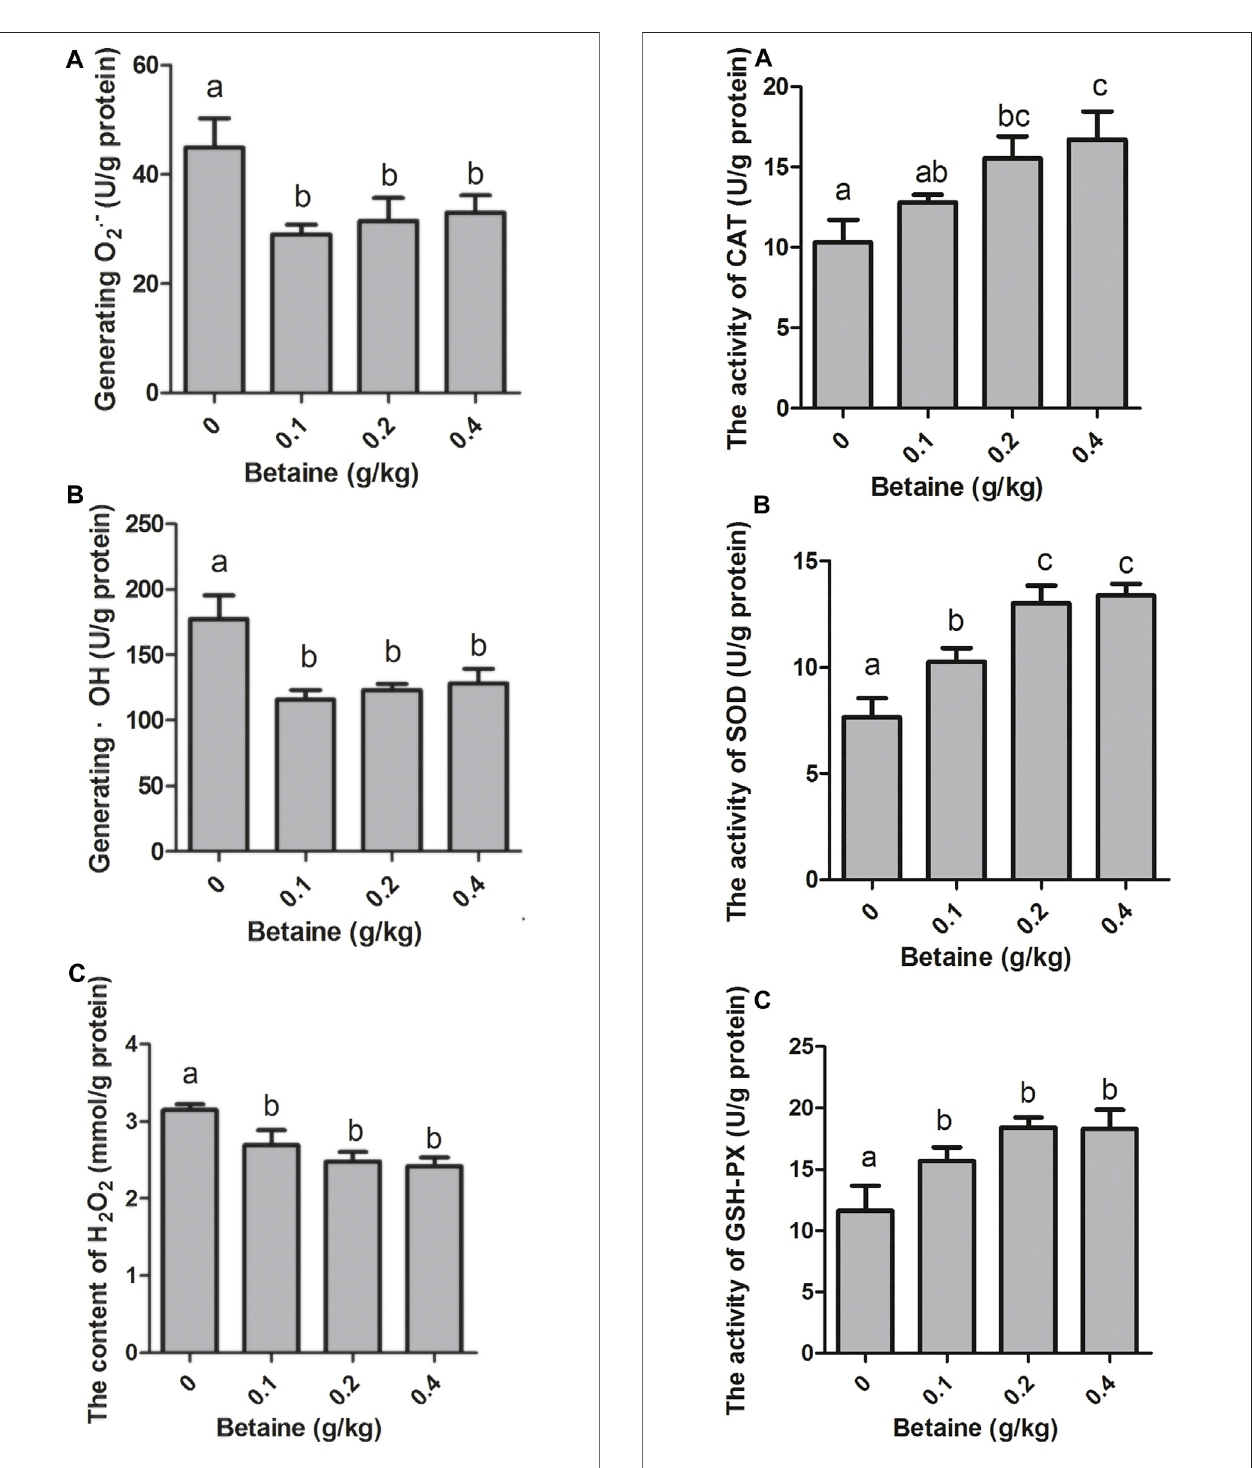
Frontiers in Physiology |